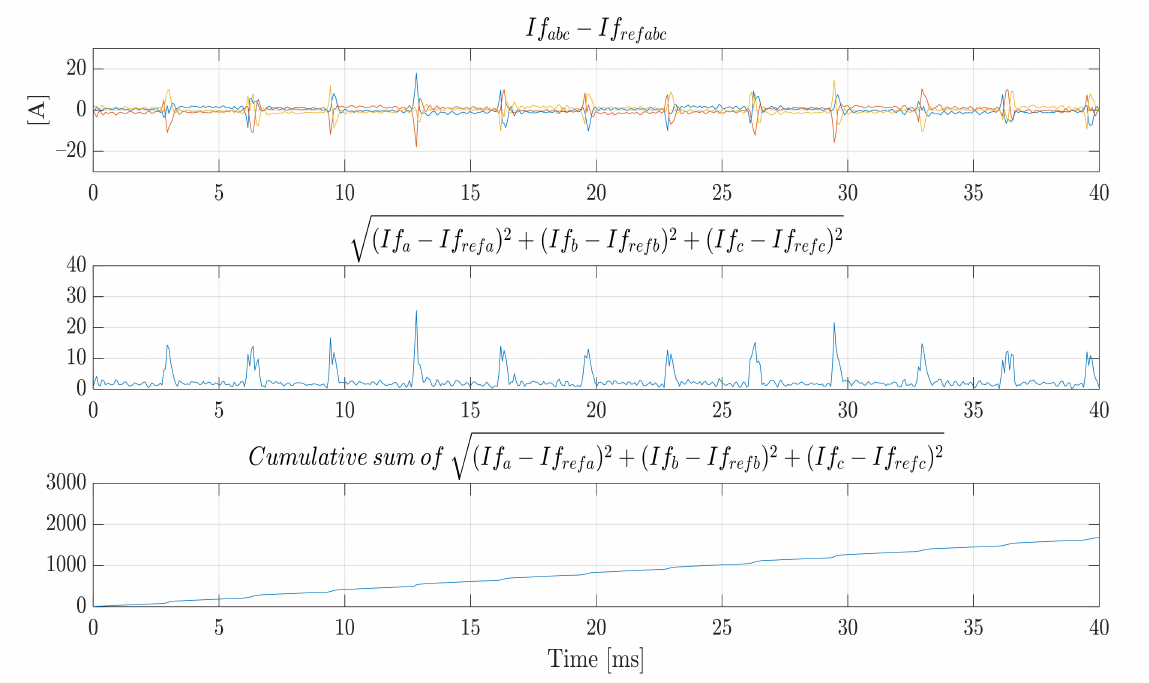
Figure 12. Error and quality factor of the optimal controller.